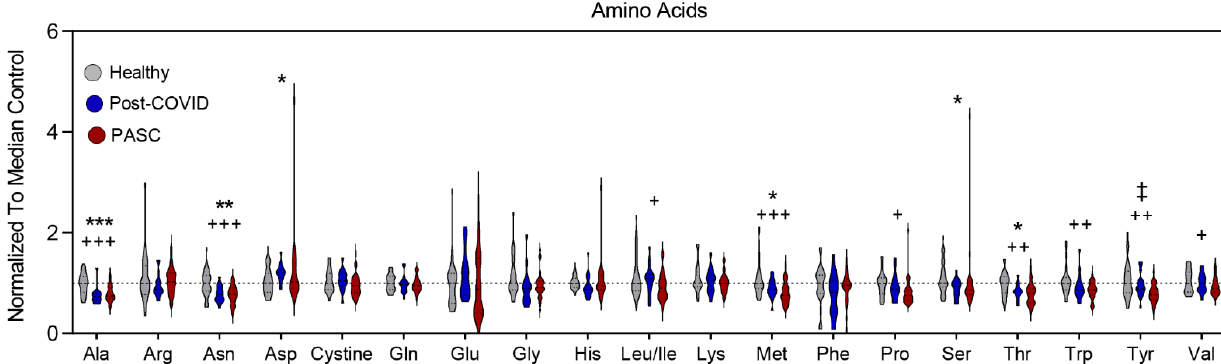
Figure 5. Changes in Amino Acids profiles. The relative levels of amino acids reported by single letter code are depicted as violin plots normalized to median control value. To identify significant comparisons, * healthy and COVID19 without PASC, + healthy and PASC, and ‡ COVID and PASC with FDR uncorrected * or + p < 0.05; ** or ++ p < 0.01, *** or +++ p <